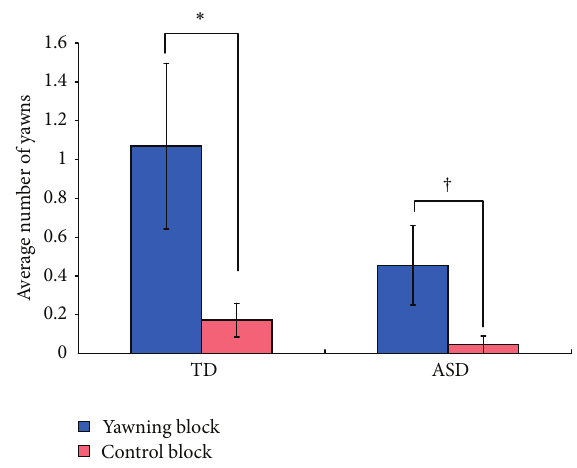
Figure 5: Average frequency of yawns of participants in yawn or control block in Experiment 2. TD: typically developing children; ASD: children with autism spectrum disorder; error bars: standard errors; ∗ 𝑃 < .05 , † 𝑃 < .10